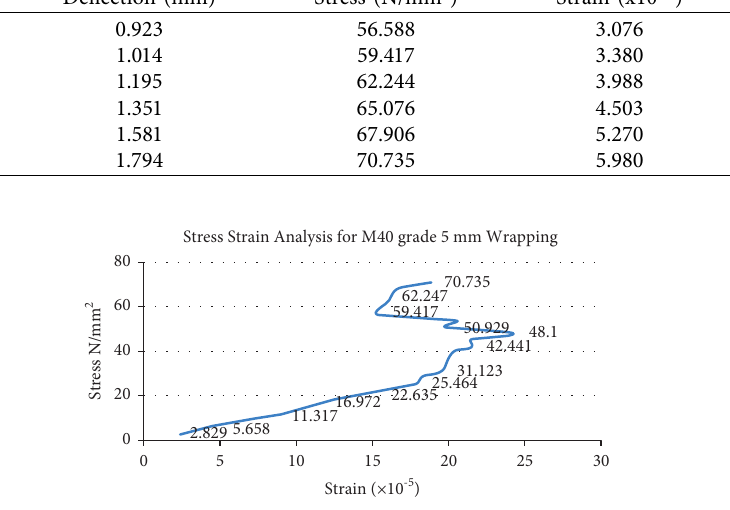
Figure 16: Stress-strain analysis for grade M40 with 5mm